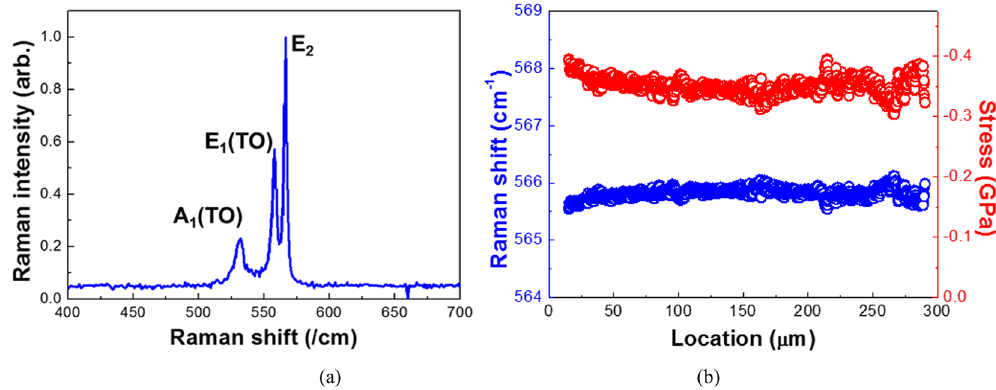
Figure 3. ( a ) Micro Raman spectrum of a freestanding GaN grown from Si substrates; GaN modes are observed at 531.3 cm − 1 (A 1 ), at 558.1 cm − 1 (E 1 ), and 566.5 cm − 1 (E 2 ); ( b ) Micro Raman intensity profiles for E 2 (high) and calculated stress as a function of the